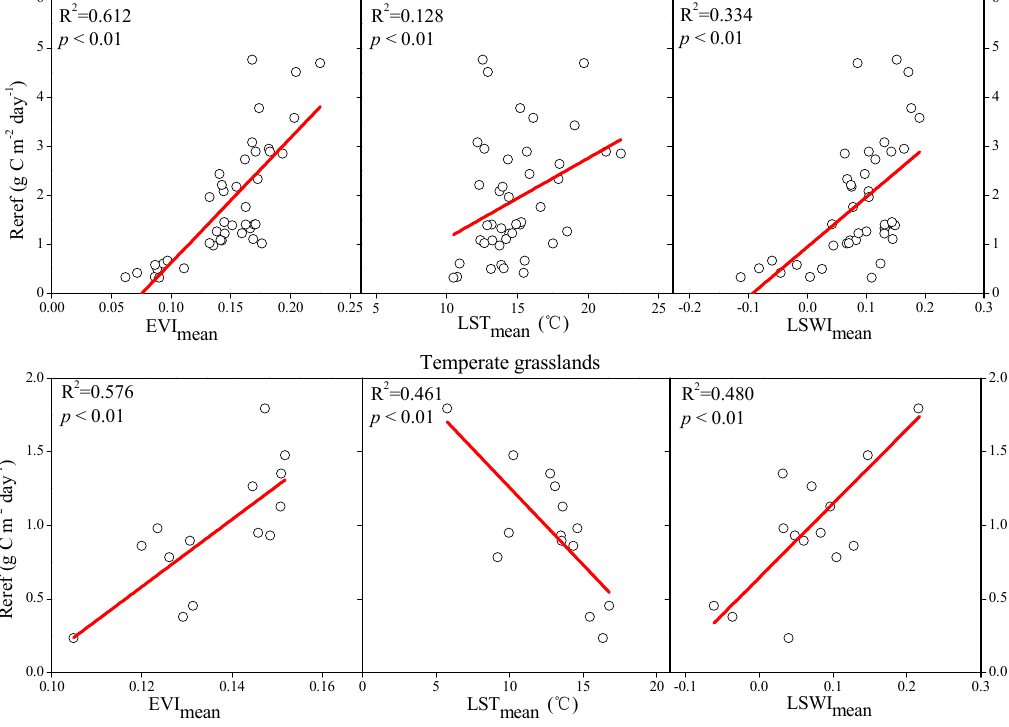
Figure 3. Reference respiration ( Reref ) response to the mean annual springtime EVI ( EVI mean ), mean annual LST ( LST mean ) and mean annual growing season LSWI ( LSWI mean ) for the Tibetan alpine grasslands and the Inner Mongolian temperate grasslands.